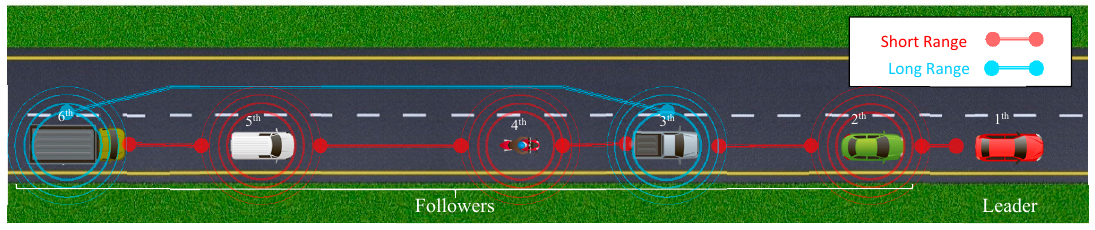
Figure 4. Graph of the small-world model.